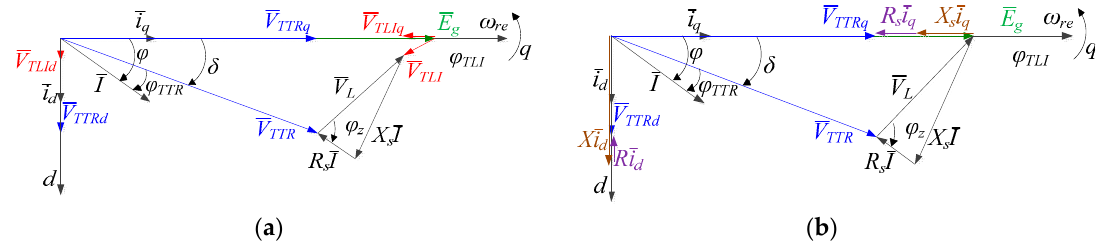
Figure 4. Vector diagram of AC variables: ( a ) considering V TLI , ( b ) neglecting V TLI .